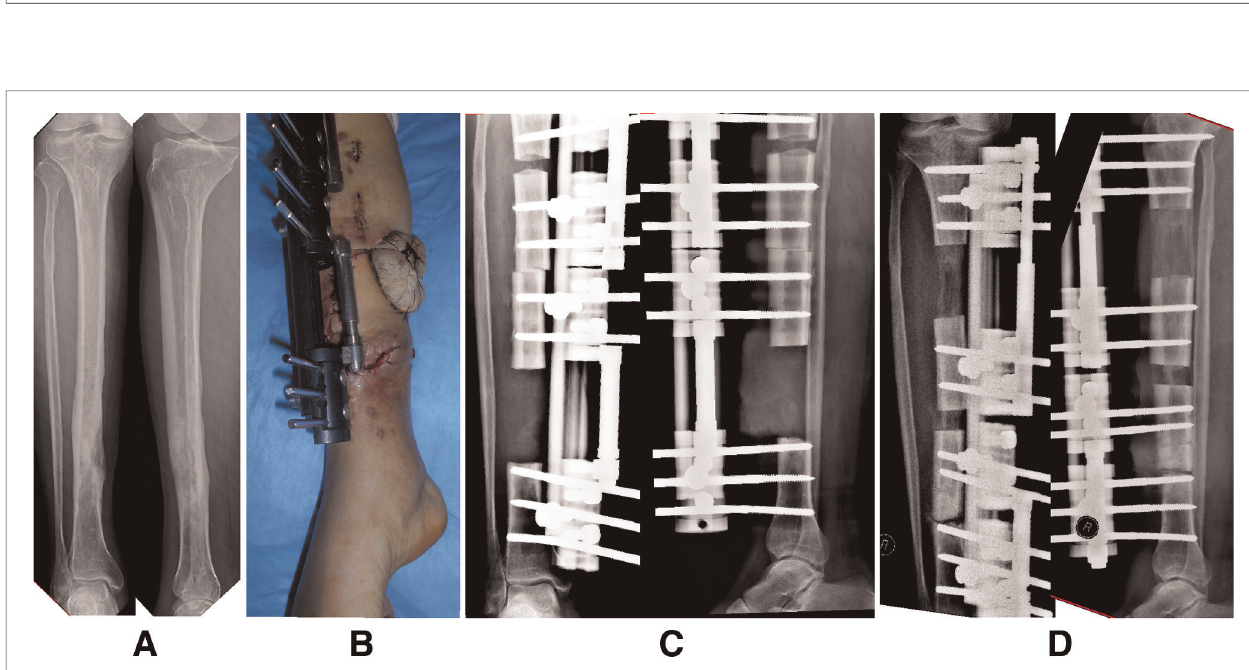
FIGURE 3 | Images of the same patient shown in Figure 2 . ( A ) Radiographs reveal the complete consolidation and docking site union. ( B ) General appearance before frame removal, showing the satisfactory range of motion of knee and ankle joint results. ( C ) Radiographs 6 months later after removing the external fi xator.